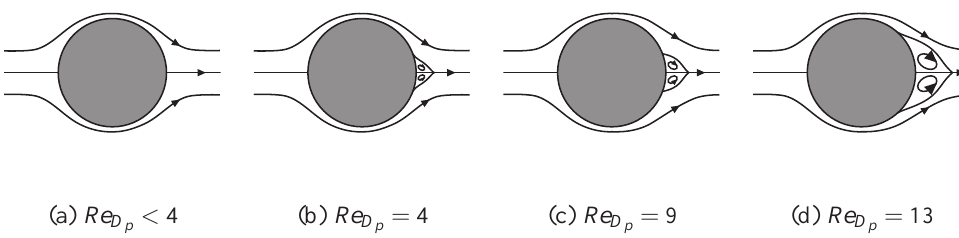
Figure 5. Two-dimensional flow field around a circular obstacle at different Reynolds num- ber Re based on the diameter D D p